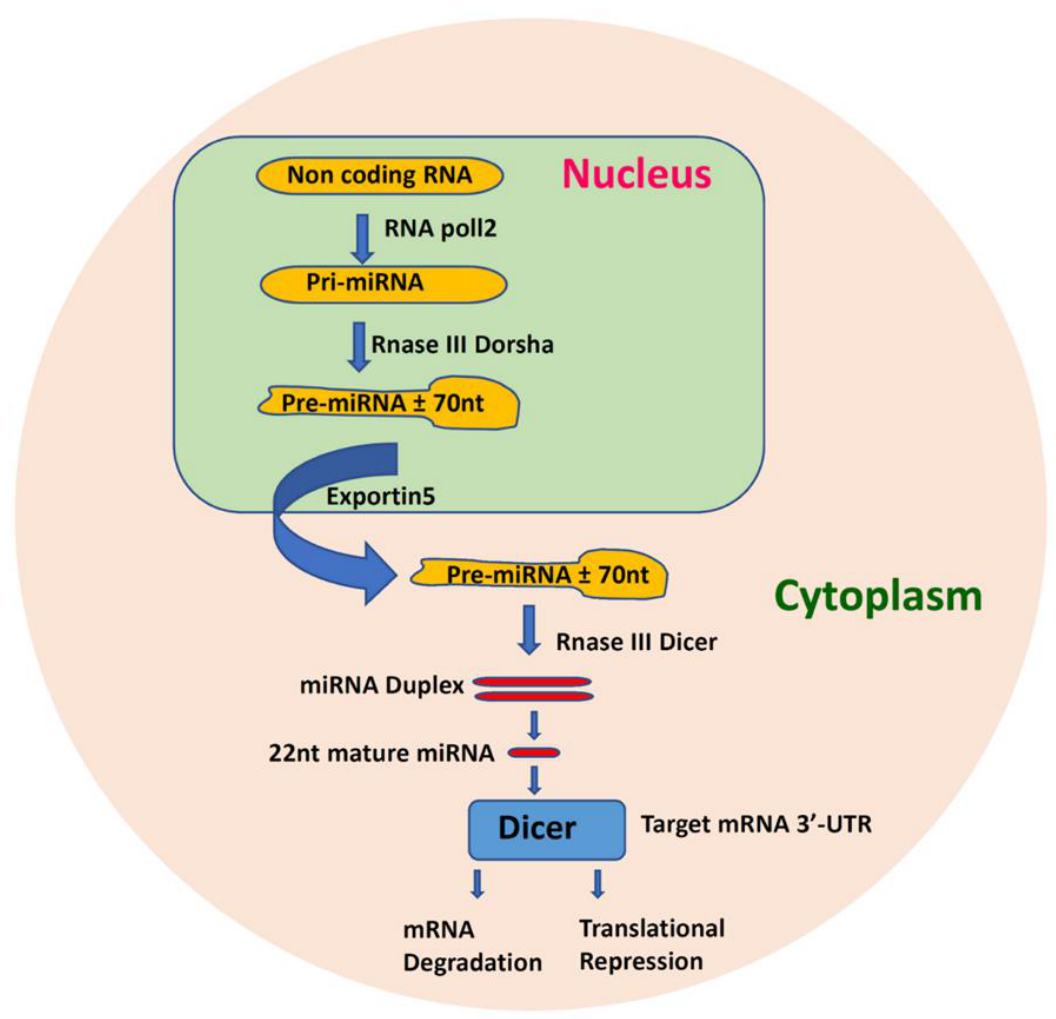
Figure 1. Brief schematic representation of the microRNA (miRNA) processing pathway. The primary transcripts of miRNAs, called pri-miRNAs, are transcribed by RNA polymerase II. The RNase III enzyme Drosha further processes the pri-miRNAs into hairpin shape precursors of 70 to 100 nucleotides (nt) called pre-miRNA, which are then exported to the cytoplasm by exportin-5 for further processing. In the cytoplasm, another RNase III enzyme, Dicer, cleaves the pre-miRNAs to form linear double stranded intermediate miRNA called miRNA duplex. The ∼ 22-nucleotide long mature miRNAs strand obtained from the intermediate duplex is then loaded into the RNA-induced silencing complex (RISC) to silence the target messenger RNA (mRNA) by destabilizing it and / or inhibiting its translation.